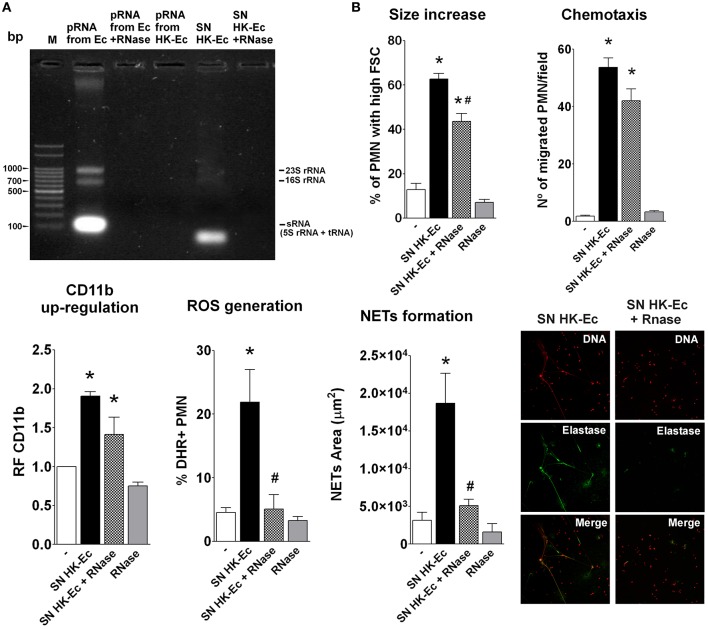
Death caused the release of RNA from bacteria. (A) Agarose gel electrophoresis stained with ethidium bromide. M-Marker: 100 bp Plus DNA ladder. (B) PMN activation was determined using the bacteria-free supernatants (SN) of HK-Ec, the SN treated with RNase (SN HK-Ec+RNase) and RNase alone by measuring different functions as detailed for Figures 1, 2. Results were expressed as the mean ± ES, n = 5. *p < 0.05 vs. non-treated PMN (−), #p < 0.05 vs. SN HK-Ec.